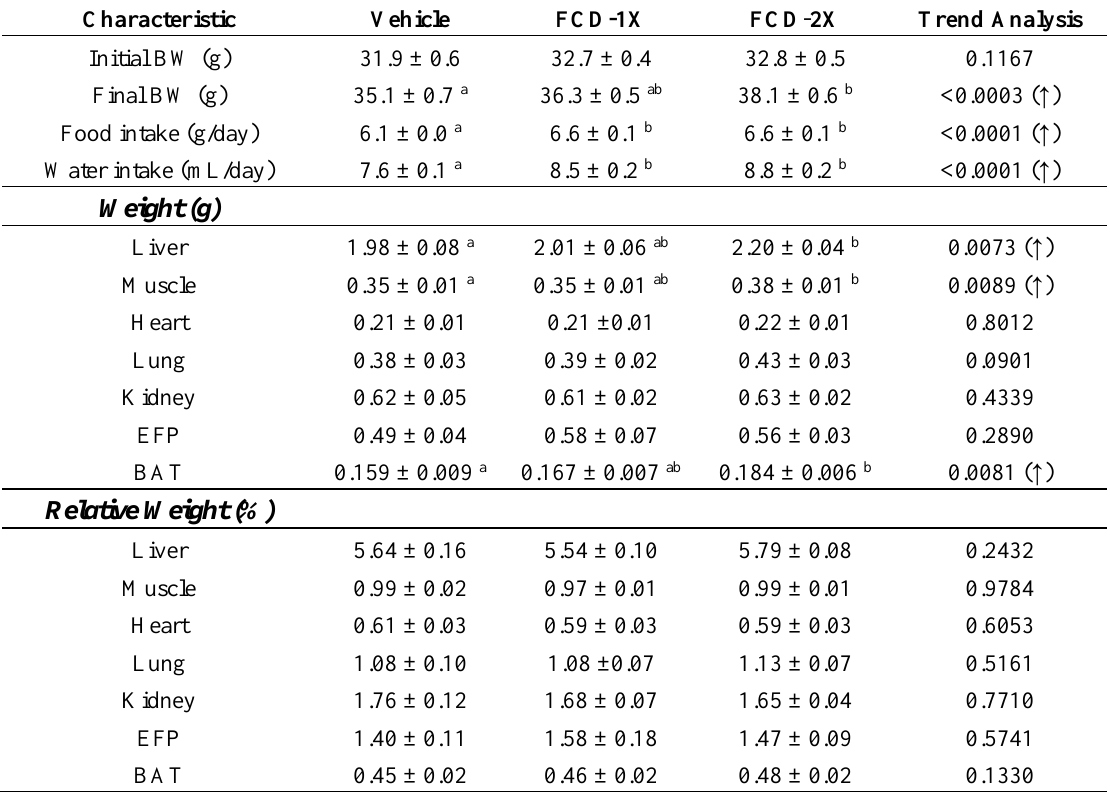
Table 1. General characteristics of the experimental